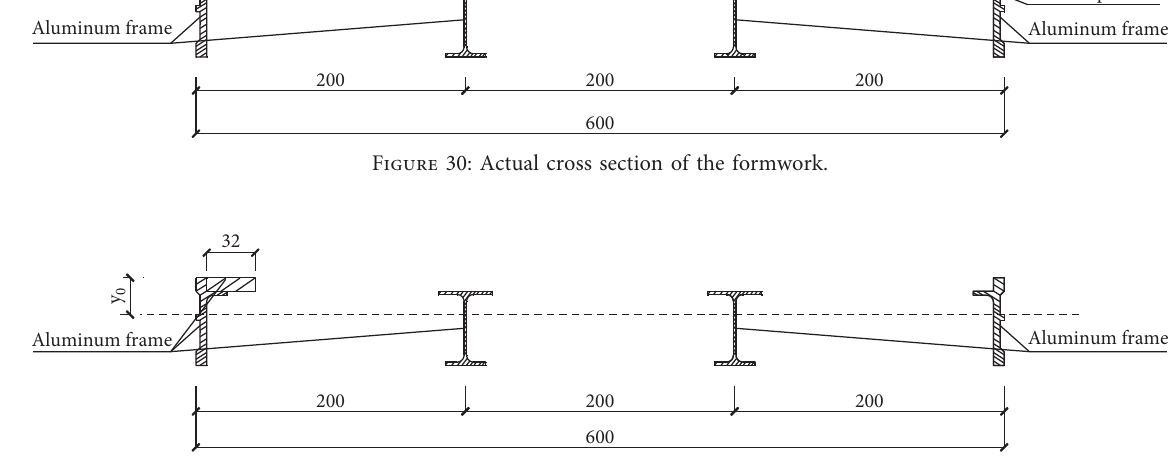
Figure 31: Equivalent cross section of the